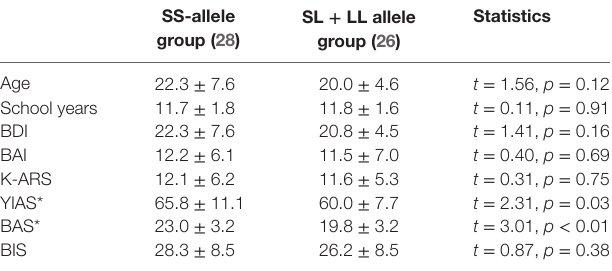
TaBle 1 | Demographic and clinical characteristics. ss-allele group